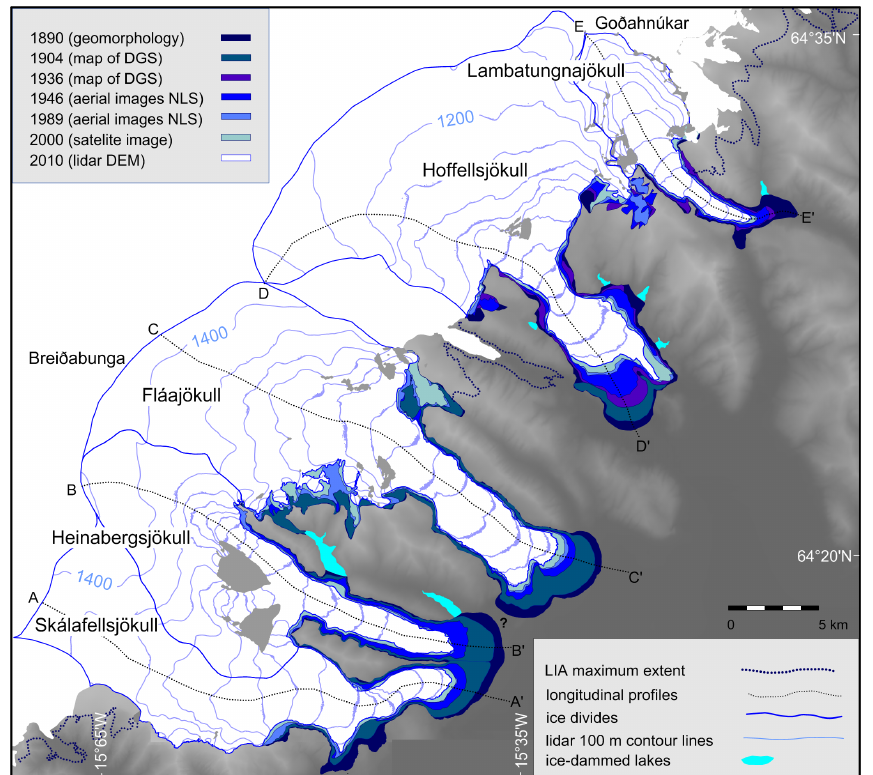
Figure 6. The extent of Skálafellsjökull, Heinabergsjökull, Fláajökull, Hoffellsjökull and Lambatungnajökull at different times. The locations of longitudinal profiles shown in Fig. 8 are indicated with capital letters (A-A’, B-B’ etc.). Surface map is derived from the lidar DEM, showing 100m contour lines. (DGS: Danish General Staff, NLS: National Land Survey of Iceland.) The ∼ 1890 glacier extent is from Hannesdóttir et al.